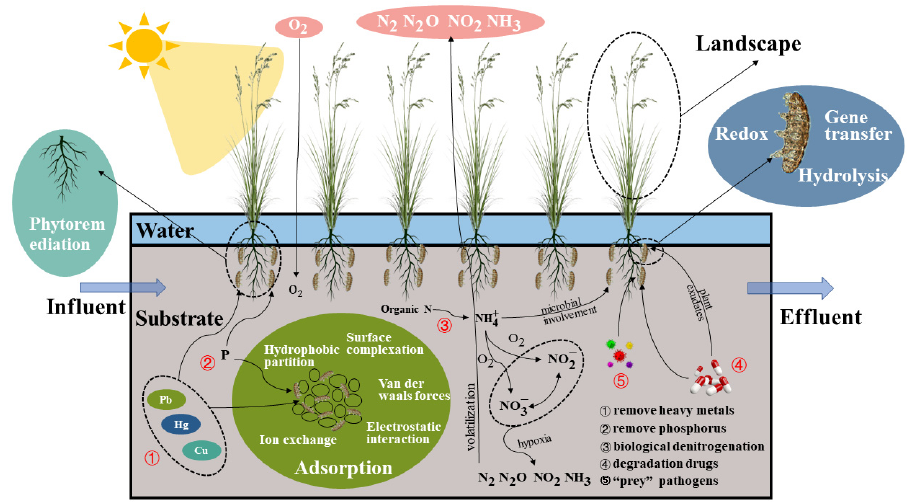
Figure 3. Mechanism of pollutant removal by components of CWs.